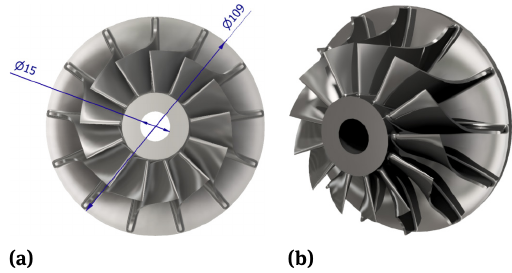
Figure 5: 3D model with dimensions (in milimetres) of turbine disc